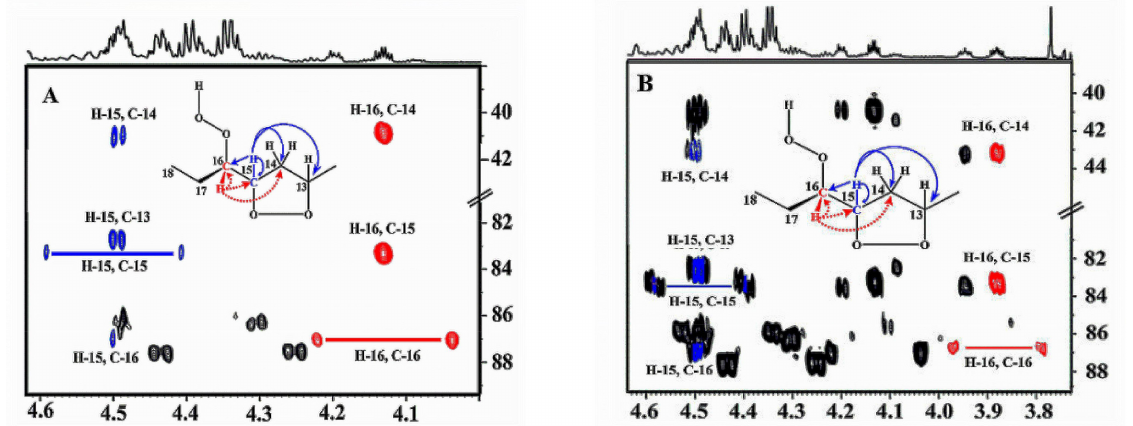
Figure 45. 1 H- 13 C HMBC correlations showing the assignments of the two diastereomeric 9- cis , 11- trans -16-OOH endo -hydroperoxides of methyl linolenate with OOH and CH-OOH resonances at 9.50 ppm and 4.3 ppm, respectively ( A ), and 9.08 ppm and 3.87 ppm, respectively ( B ). The critical connectivities of the H-15 with C-14, C-13, C-15 ( 1 J ( 13 C, 1 H)), C-16, and connectivities of H-16 with C-14, C-15, and C-16 ( 1 J ( 13 C, 1 H)) are illustrated [138].